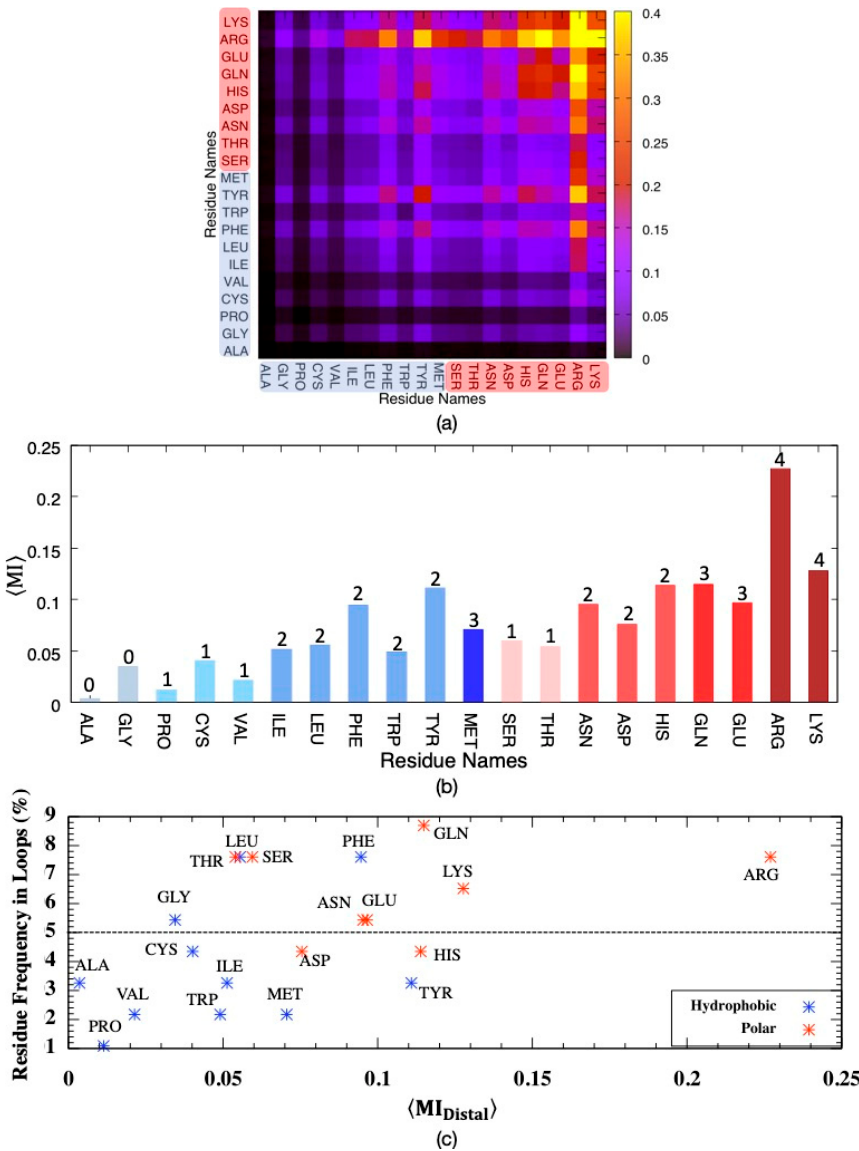
Figure 4. Mutual information for pairs of distal residues classified as either hydrophobic (blue tones) or polar (pink tones) considering all backbone (𝜙, 𝜓) and side-chain torsion angles (𝜒 (cid:3038) , 𝑘 = 0, 1,2,3,4) , averaged over ( a ) residue pairs, ( b ) residue types with the number of side-chain torsion angles 𝑘 and ( c ) residue frequency in loop regions versus average MI.